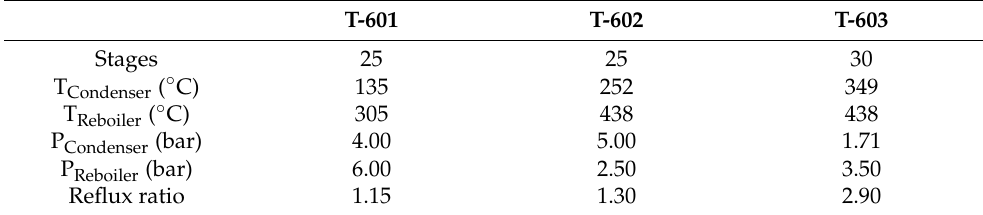
Table 6. Main parameters of the rectification columns (T-601/T-602/T-603, see Figure